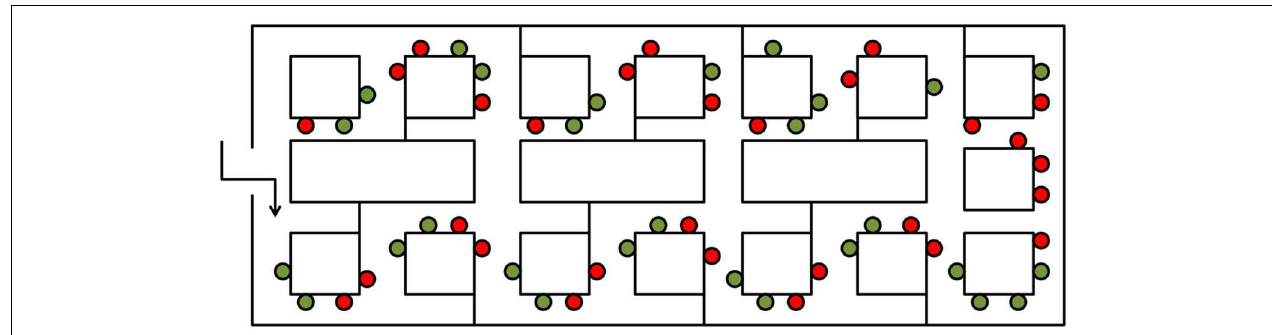
FIGURE 2 |The influence of spatial location on object processing adapted from Janzen and vanTurennout (2004). An aerial schematic of the virtual museum used by Janzen and vanTurennout (2004). Red dots indicate locations of decision point objects, and green dots indicate locations of non-decision point